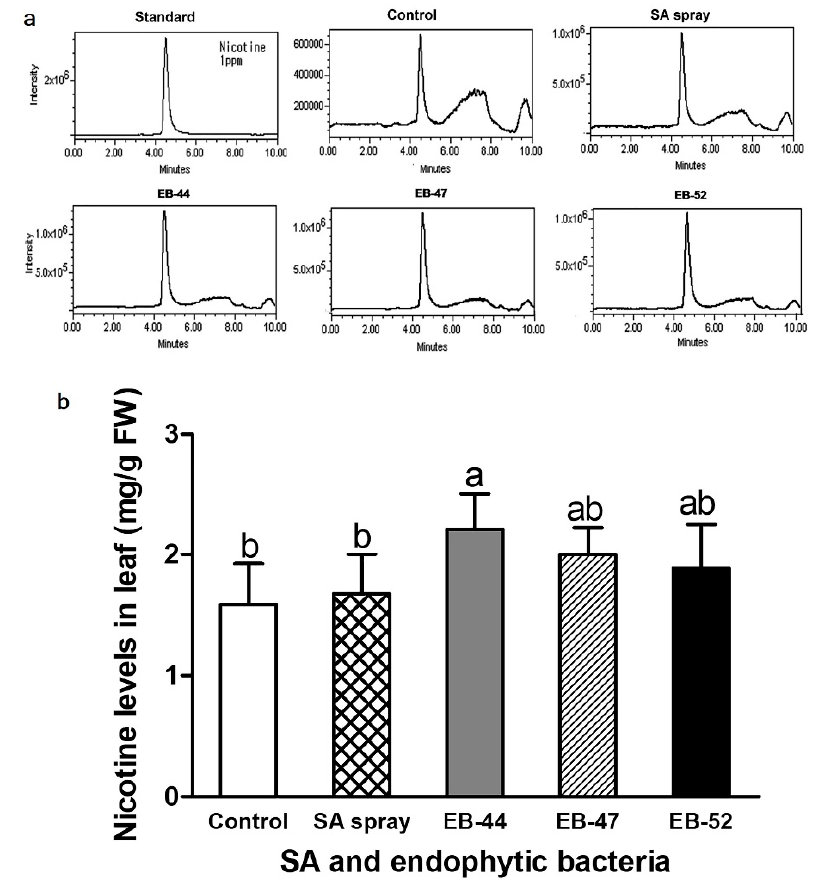
Figure 6. Liquid chromatography–mass spectrometry (LC–MS) analysis for the identification and quantification of nicotine levels in the leaves of Nicotiana tabacum treated with salicylic acid (SA)-producing endophytic bacteria (EB) or SA sprayed on plant leaves. ( a ) Completely matched LC–MS chromatograms of the standard sample with the nicotine peak at 4.49 min and the EB-44 sample with the peak at 4.49. ( b ) Nicotine content in the leaves of N. tabacum. Data represent means ± standard deviations of four independent replications for each treatment. Means with different letters are significantly different at p < 0.05 by Duncan’s multiple range test. FW = fresh weight.